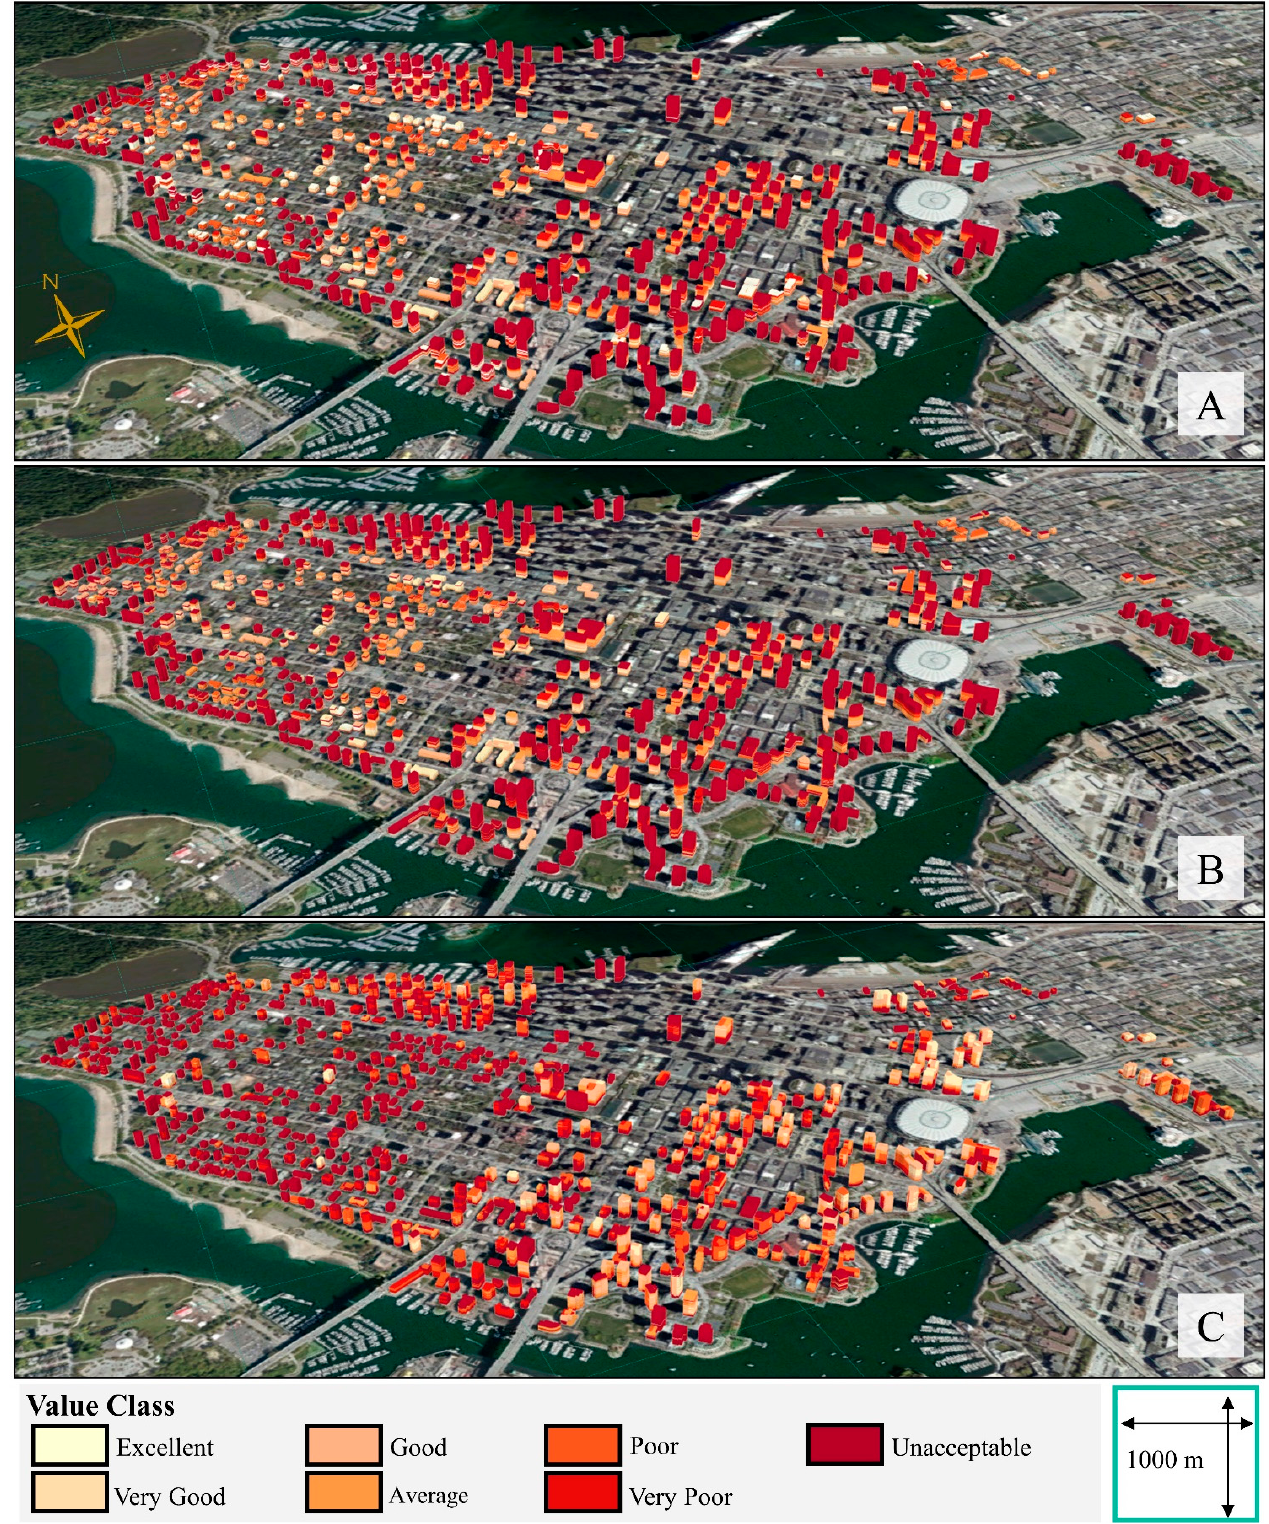
Figure 10. Results of the cost–suitability analysis for ( A ) Scenarios 1, ( B ) 2, and ( C ) 3.